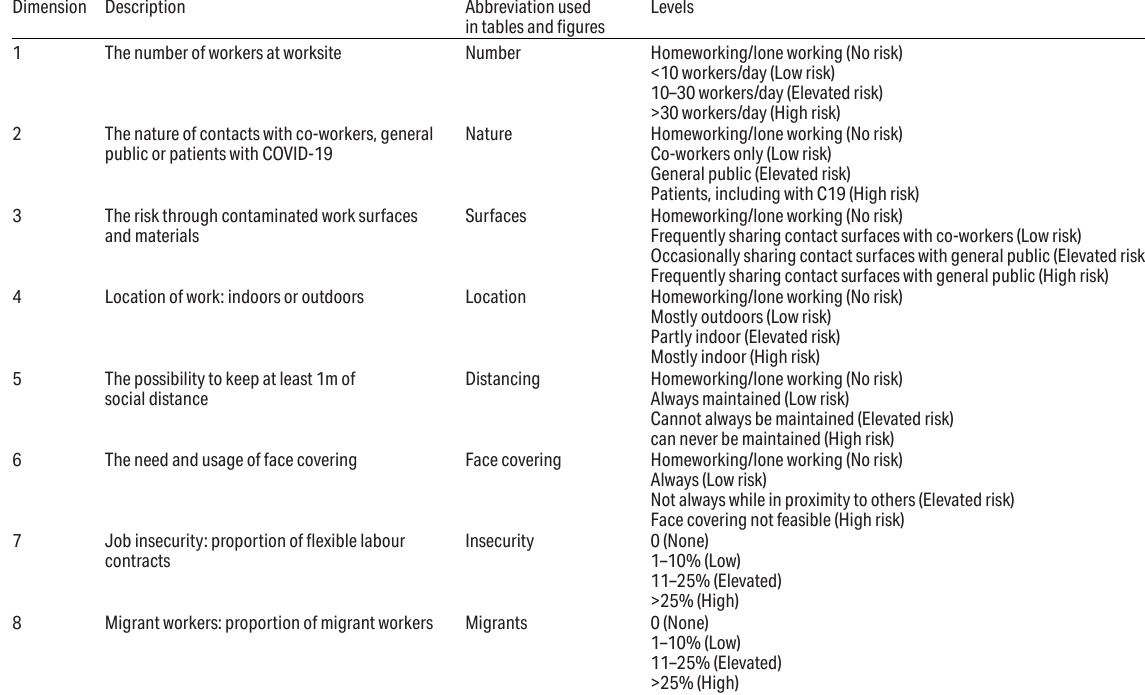
Table 1. Description of 8 domains of the job exposure matrix (JEM). Dimension